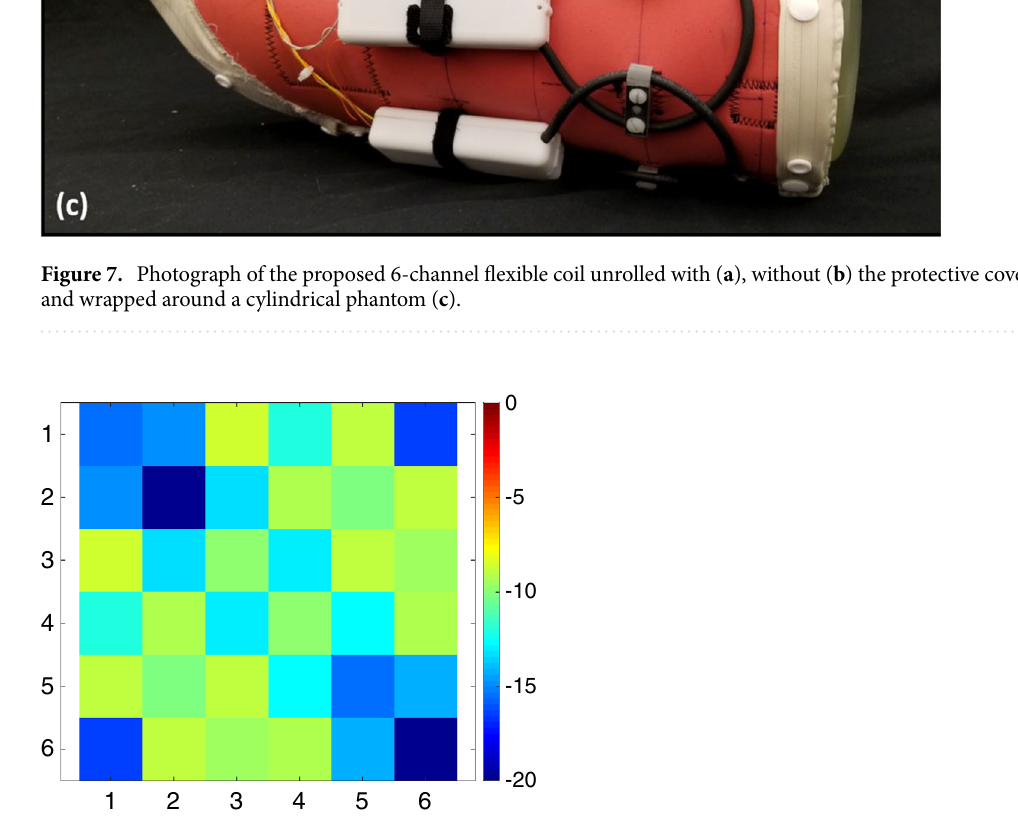
Figure 8. The 6 × 6 scattering matrix of the cable coil wrapped around a phantom as shown in Fig. 7. Scale in dB.